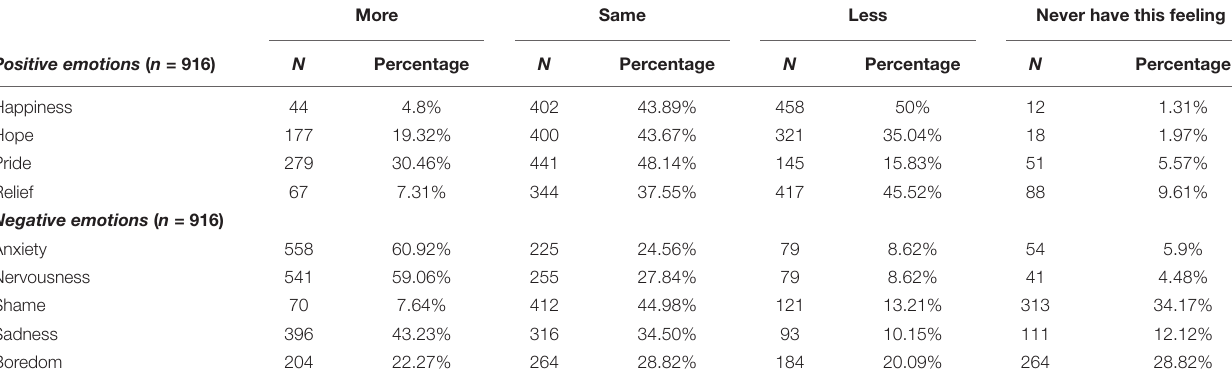
TABLE 4 | Changes in teachers’ emotions during emergency remote